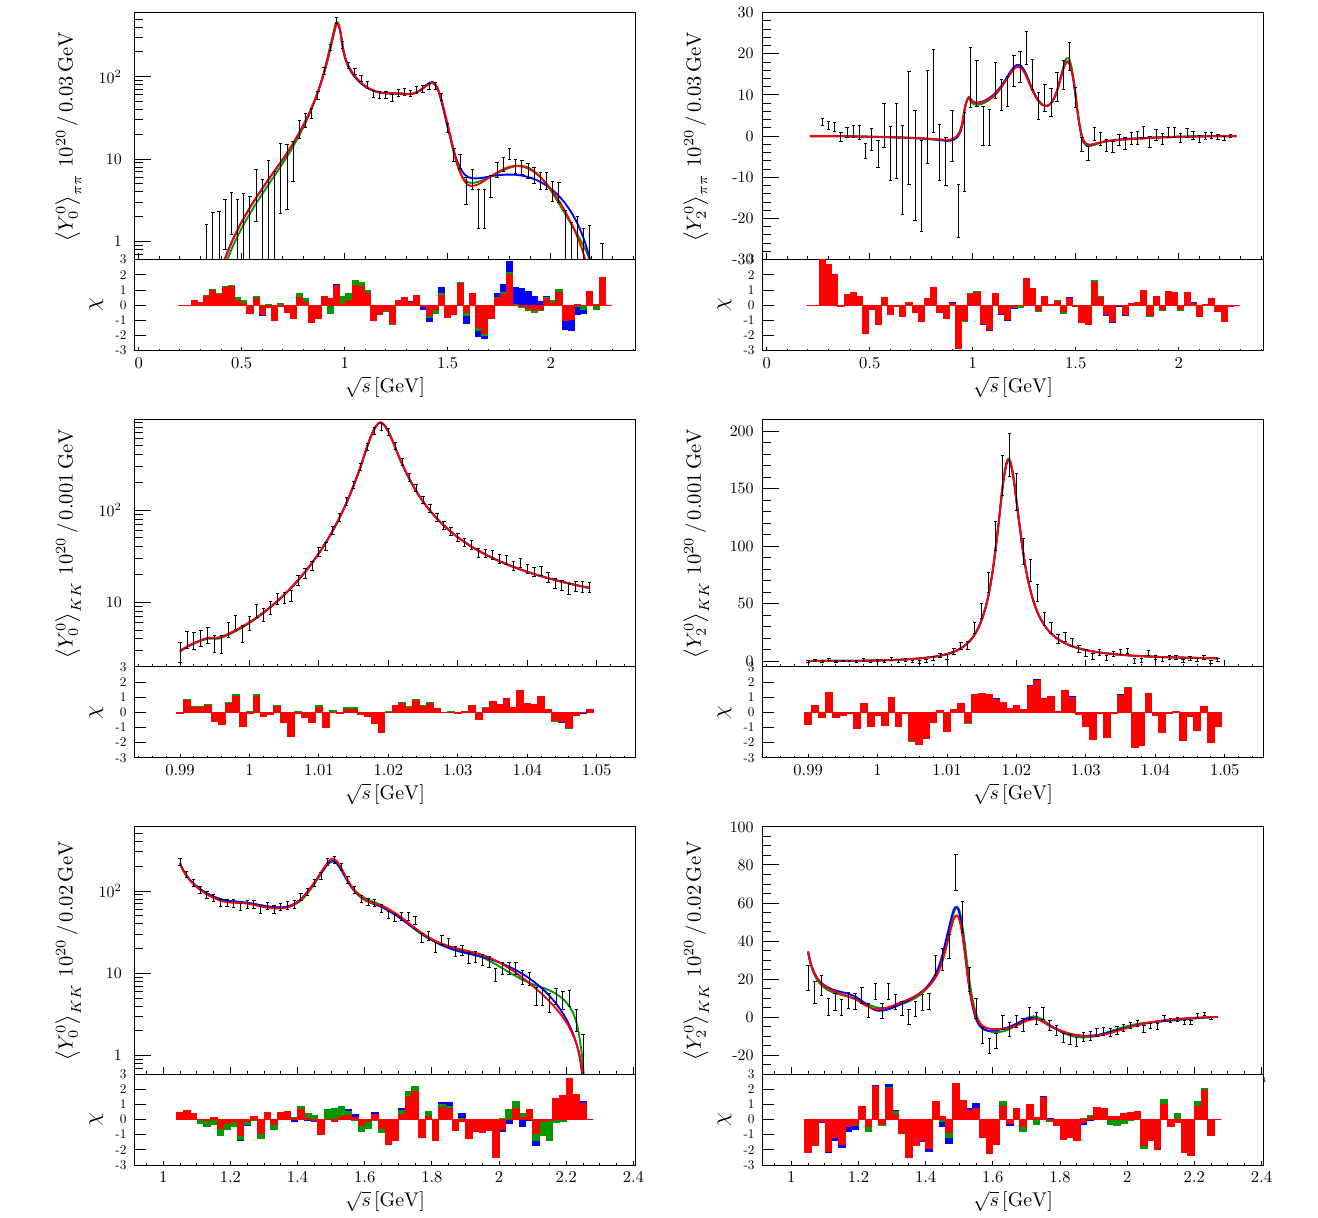
(cid:2) (cid:3) (cid:2) (cid:3) Y 0 Y 0 and for the decay ¯ B 0 s → 0 2